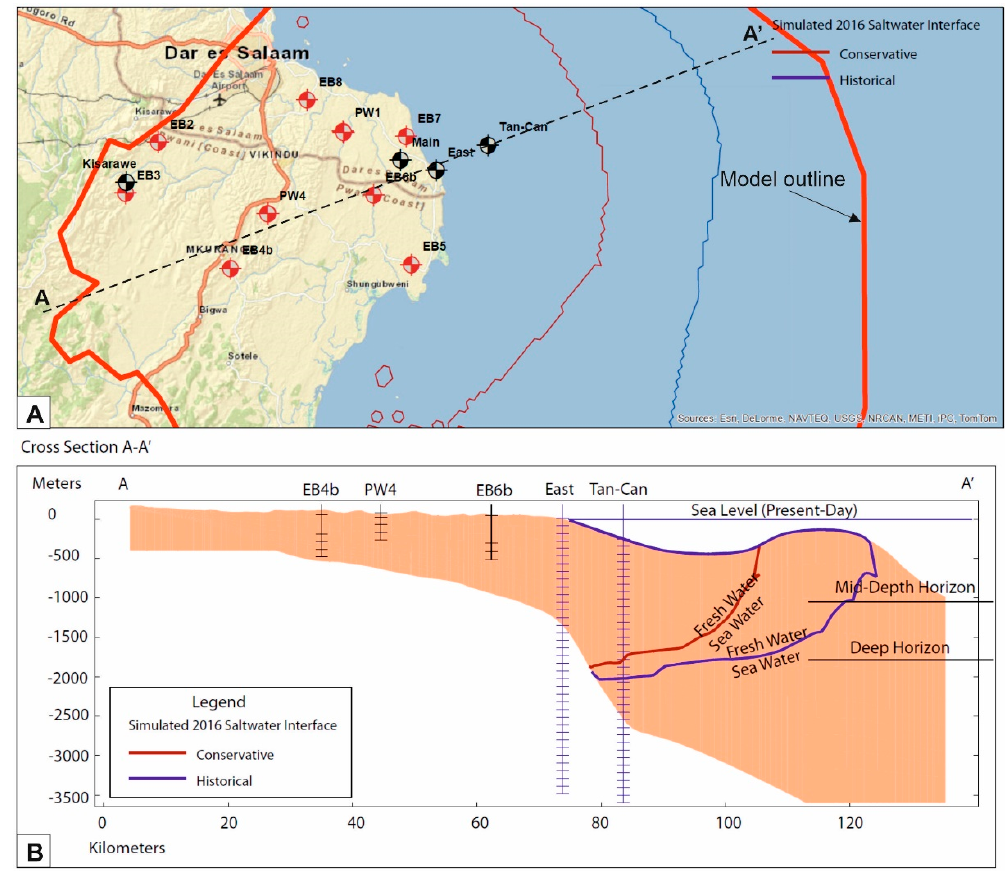
Figure 14. Simulated positions of the fresh and saline groundwater interface. ( A ) Location map, with red symbols representing 600 m deep groundwater exploration wells, and black symbols representing oil & gas exploration wells drilled in the early 1980s. The dashed line A-A’ is the location of the cross-section shown in ( B ). The red and blue lines show the two modelling scenarios detailed in ( B ), as projected in plain view at the “mid-depth horizon” in the aquifer system (c. 1 km below sea level) (Figures modified from: [140]). ( B ) Simulated extent of the fresh-saline groundwater interface along cross-section A-A’, whereby the red “conservative scenario” is defined by current measured groundwater and sea water levels and the blue “historical scenario” accounts for lower sea levels during the Pleistocene and Holocene.